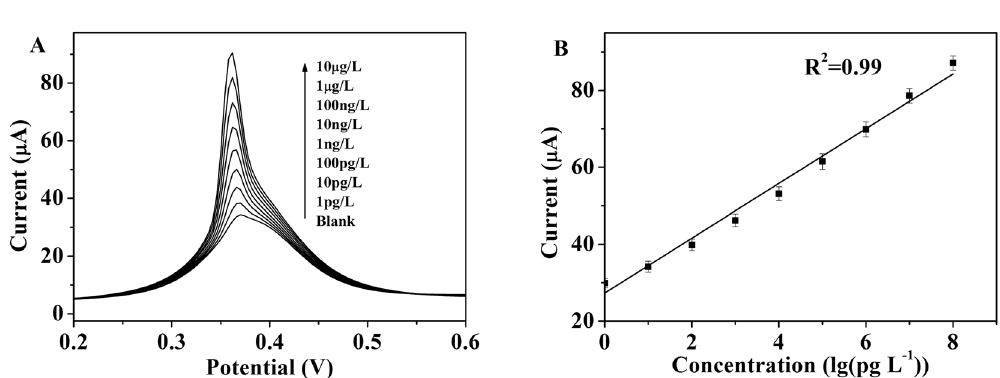
Figure 3. ( A ) Differential pulse voltammograms (DPV) of the RGO-AuNP-Aptamer/Au biosensor at different concentrations of PCB77 ranging from 1 pg L − 1 to 10 µ g L − 1 , respectively. Pulse amplitude, 50 mV; pulse period, 0.2 s. ( B ) The increase of the peak current for PCB77 at different concentrations. The standard deviations are all less than